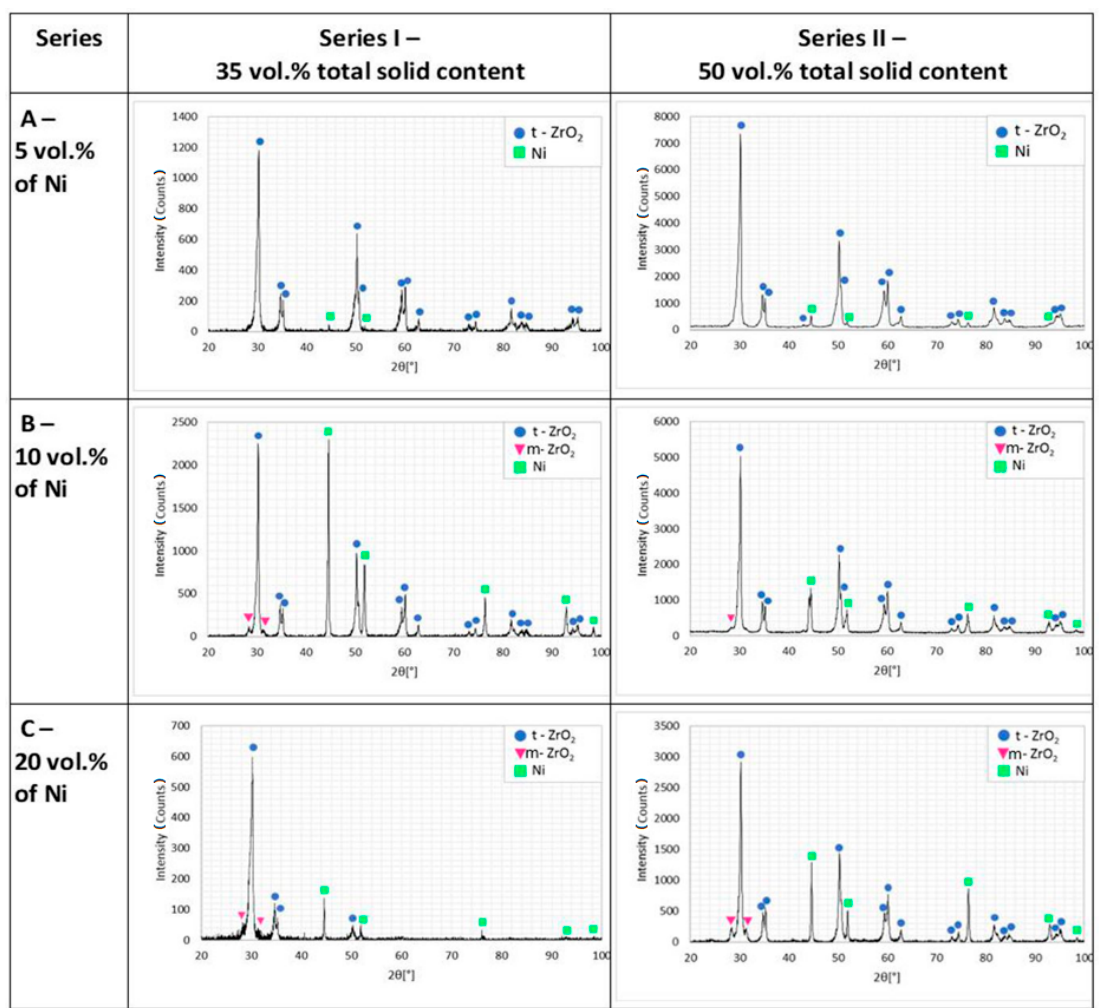
Figure 11. Diffractograms of composites after the sintering process.